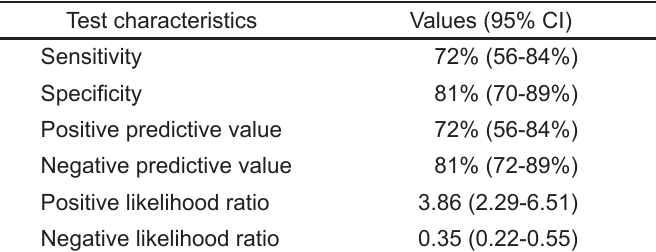
Table 2. Calculated test characteristics assuming all non- diagnostic bedside ultrasound studies were deemed negatives at the